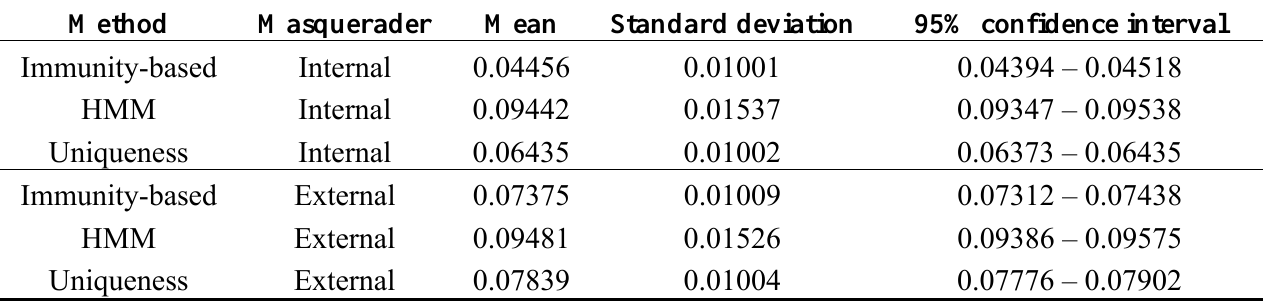
Table 1. Statistics on the area under the ROC curves for detection of internal masqueraders and external masqueraders using our immunity-based method, the single-sensor HMM method and the uniqueness method.